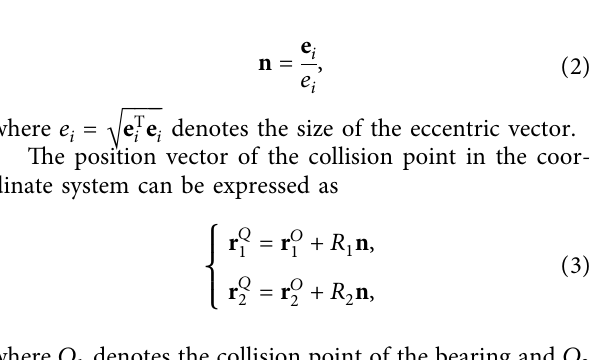
Figure 1: Bearing and shaft clearance model. (a) Free flight mode. (b) Contact mode. (c) Impact